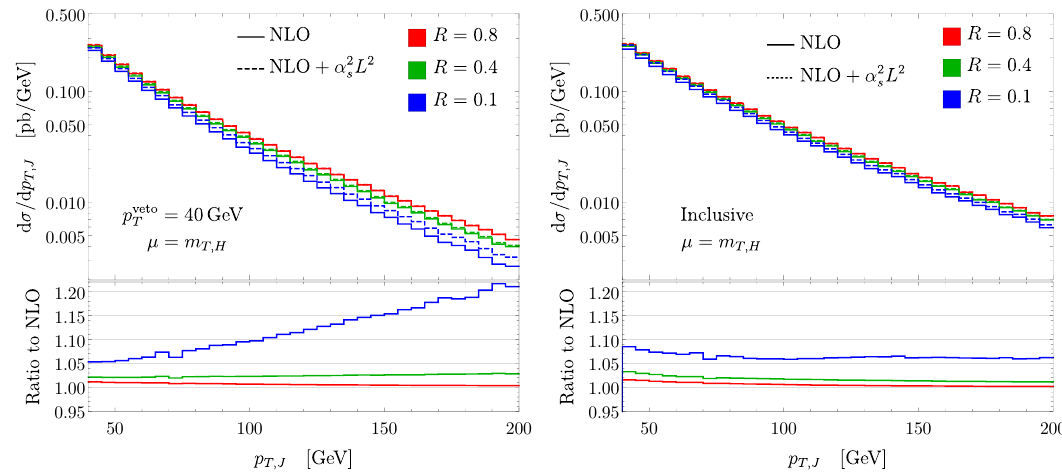
Figure 6 . The Higgs + 1 jet cross section di(cid:11)erential in the jet transverse momentum at NLO (solid lines) and NLO + (cid:11) 2 ln 2 R corrections (dashed lines) for R = 0 : 8 ; 0 : 4 ; 0 : 1 (red, green, blue). s The left plot shows the exclusive cross section with a loose p veto = 40 GeV, while the right plot T shows the inclusive cross section. The lower panels show the ratio of the NLO + (cid:11) 2 ln 2 R predictions s with the corresponding NLO